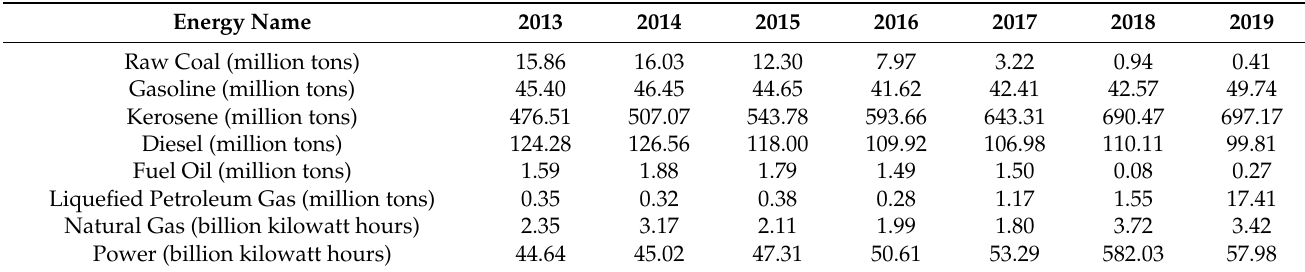
Table 2. Energy consumption by region in Beijing.